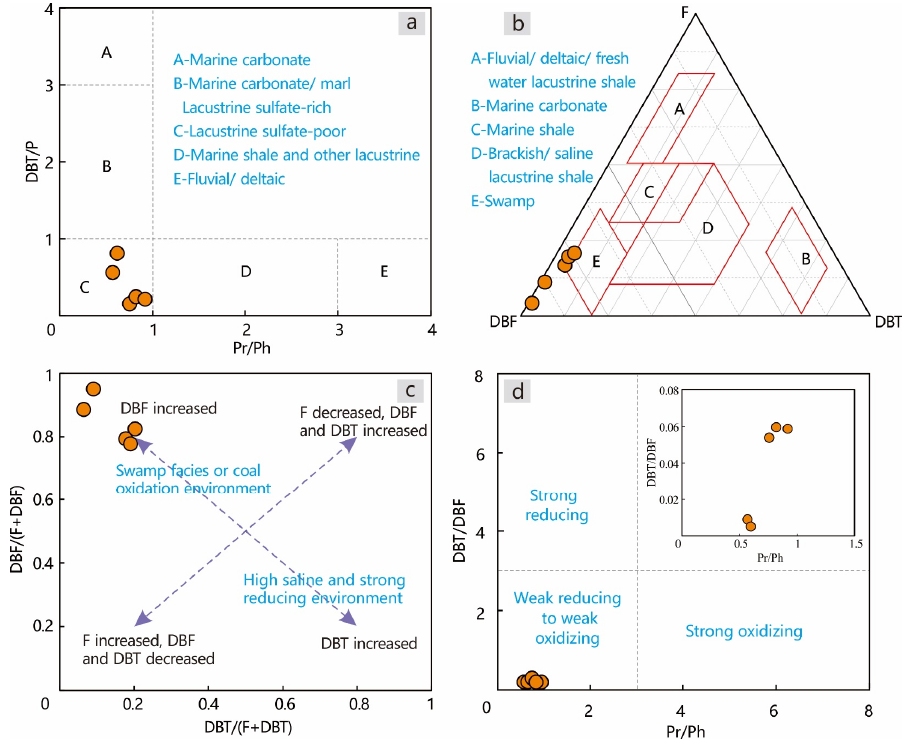
Figure 11. Discrimination diagram of sedimentary environment. ( a ) Crossplot of Pr/Ph versus DBT/P; ( b ) ternary diagram of DBF–DBT–F; ( c ) binary plot of DBT/(F + DBT) versus DBF/(F + DBF); ( d ) crossplot of Pr/Ph–DBT/DBF.